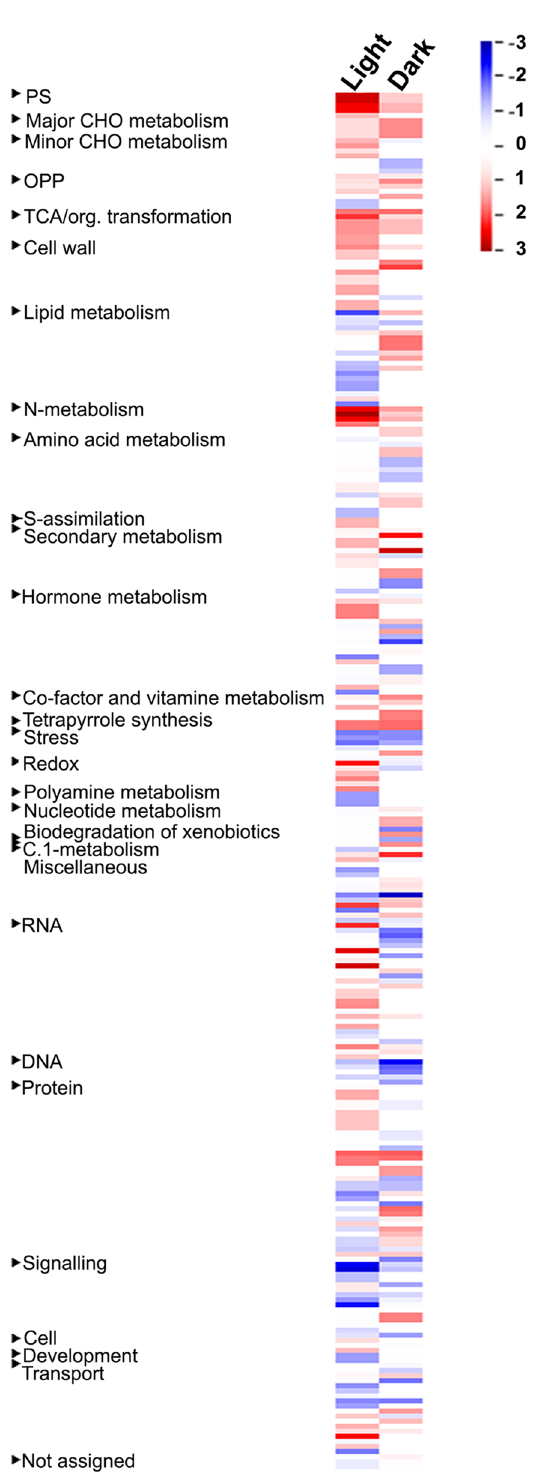
Figure 3. PageMan analyses of nitrate-responsive transcripts differentially expressed between light and dark conditions. Over- and under-represented nitrate-responsive pathways in light and dark conditions were analyzed in PageMan (https ://mapma n.gabip d.org/pagem an) using Wilcoxon algorithm with default parameters. Bin names are shown to the left of the image and treatment conditions are mentioned at the top of the image. Significant functional groups are indicated by either red (over-represented) or blue (under- represented) colour according to the scale and details are provided in Fig.